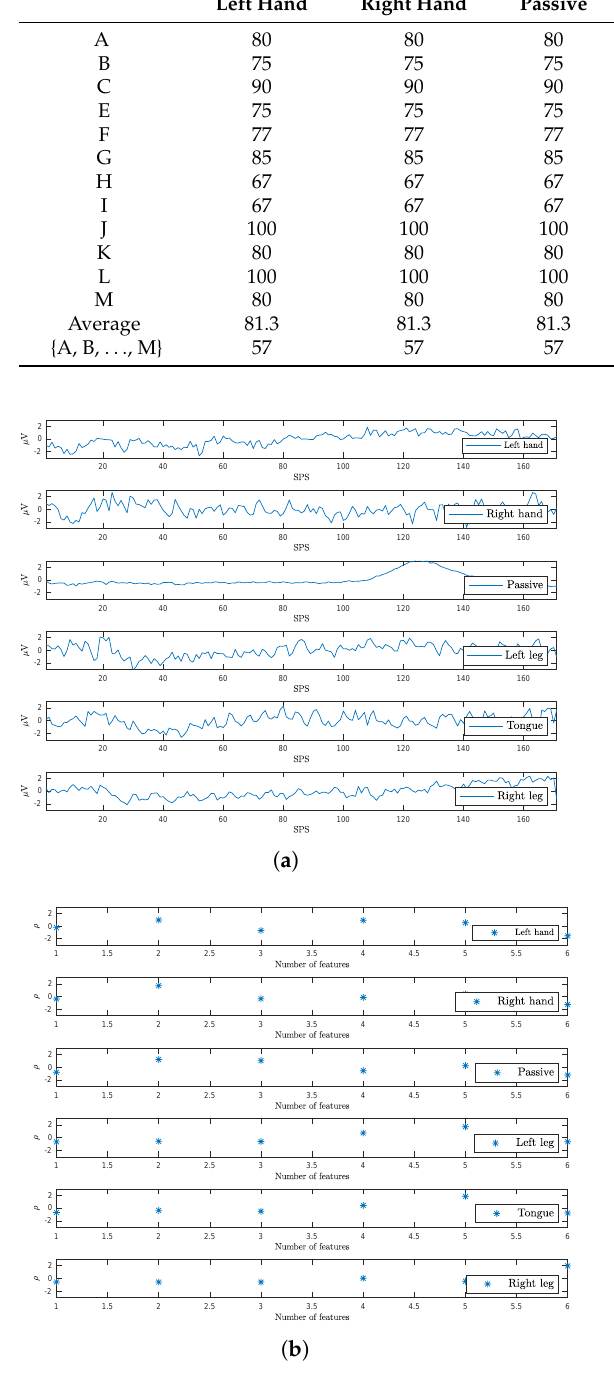
Figure 6. Illustration of MI–EEG features before and after the classification using the EEGNet network. In this example, subject J’s data are provided by the Fp1 channel. The window was set to 170 samples, corresponding to task duration. The normalized magnitude is given in µ V, while SPS and ρ mean the number of samples per second and feature magnitude, respectively. ( a ) MI–EEG signals before classification. ( b ) MI–EEG features after